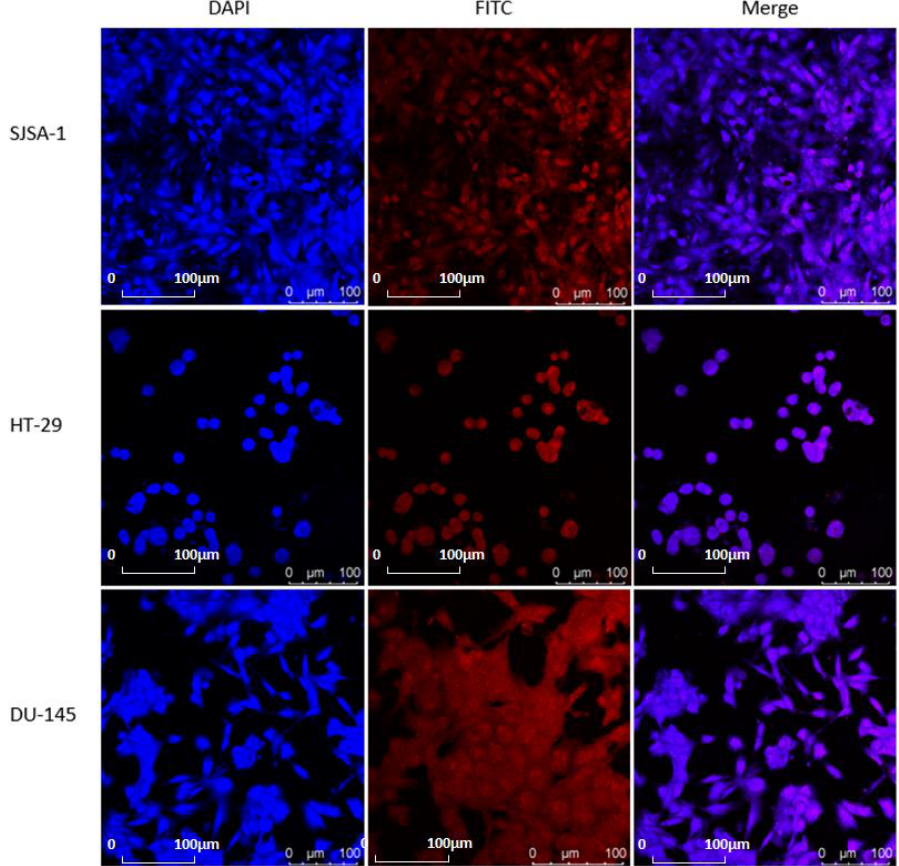
Figure 7. In vitro cellular uptake of M-3 in three cancer cell lines and one normal cell line. Cells were incubated with M-3 at a concentration of 1.0 μM for 12 h.